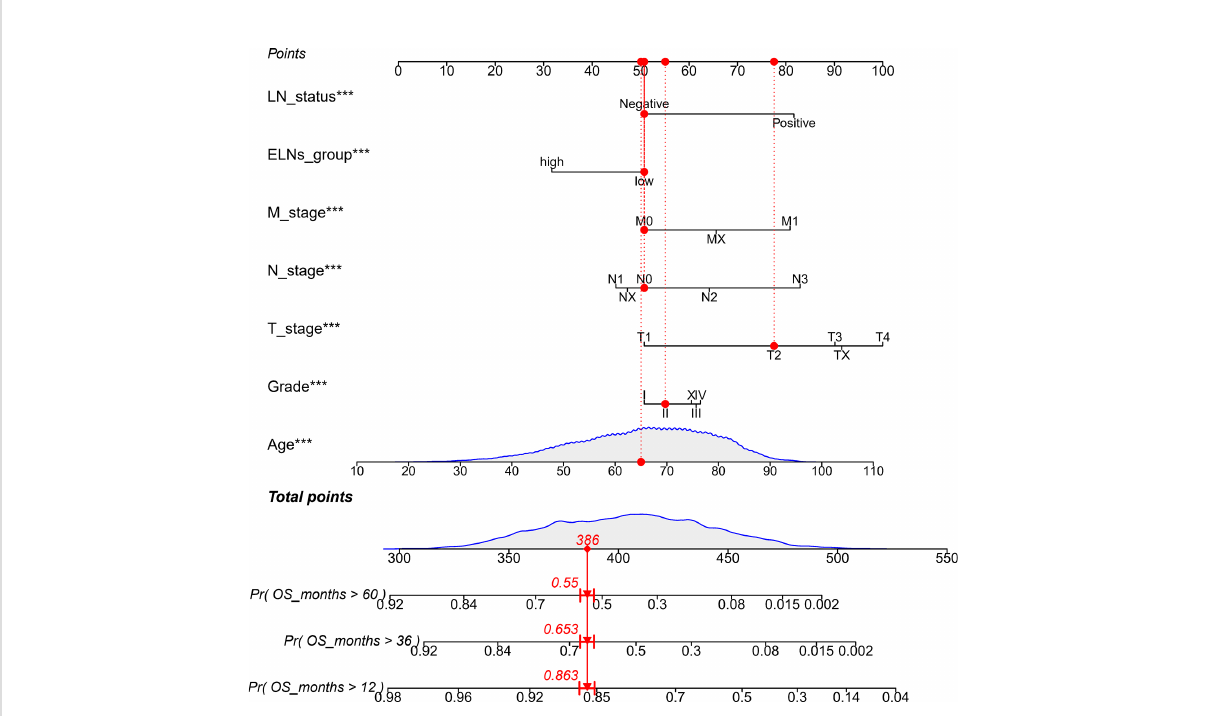
FIGURE 4 Nomogram to predict the OS of GC patients. ELNs, the number of examined lymph nodes; LN status, lymph node status; OS, overall survival; GC, gastric cancer. ***p <